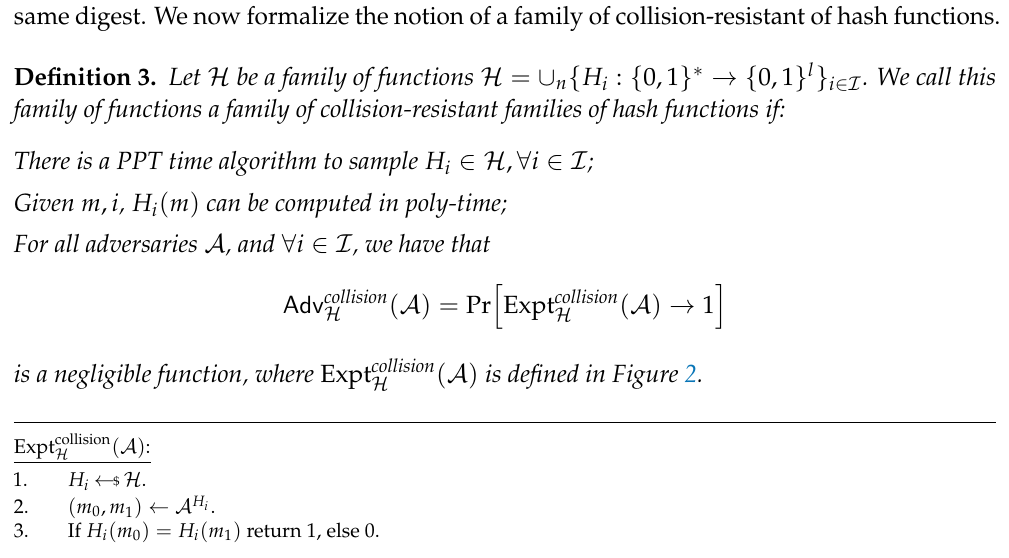
Figure 2. The collision-resistance security experiments for the hash function family H